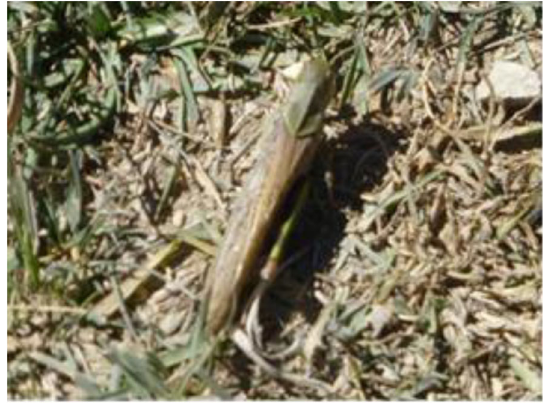
Fig. 11 Grass Hooper, the insect which attacks buckwheat